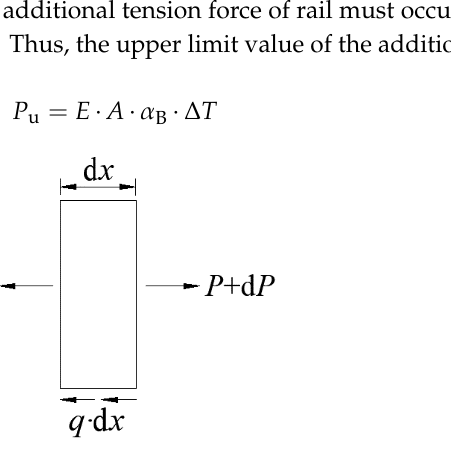
Figure 8. Longitudinal forces acting in the mini segment of rail.